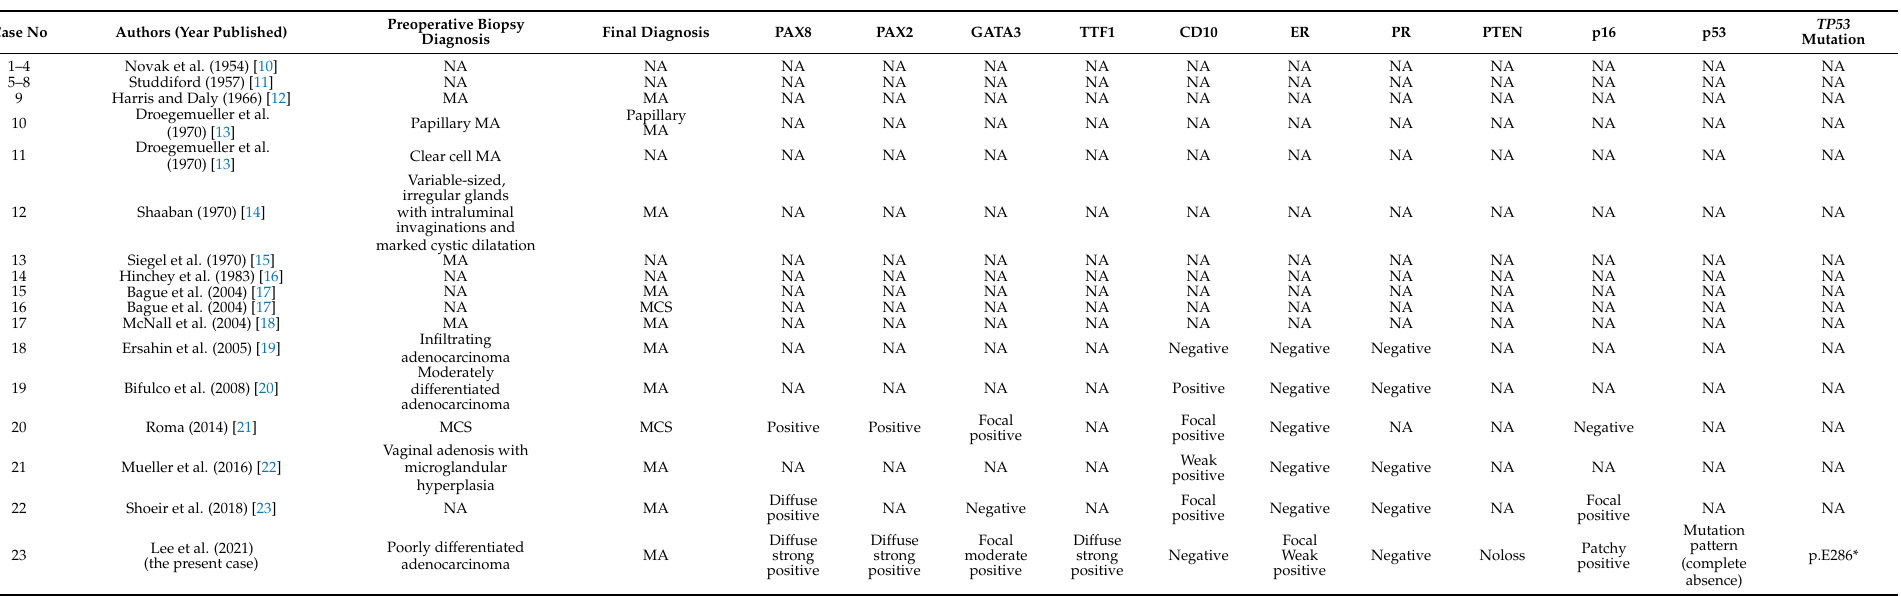
Table 3. Pathological characteristics, immunophenotypes, and TP53 mutational status of vaginal mesonephric adenocarcinoma.